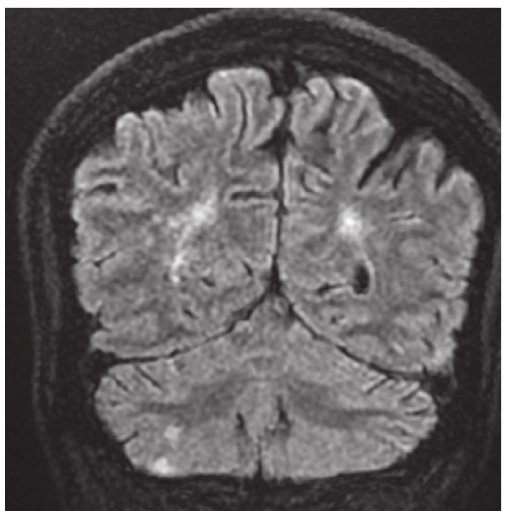
Figure 3: Coronal view of MRI brain showing the right cerebellar infarct.